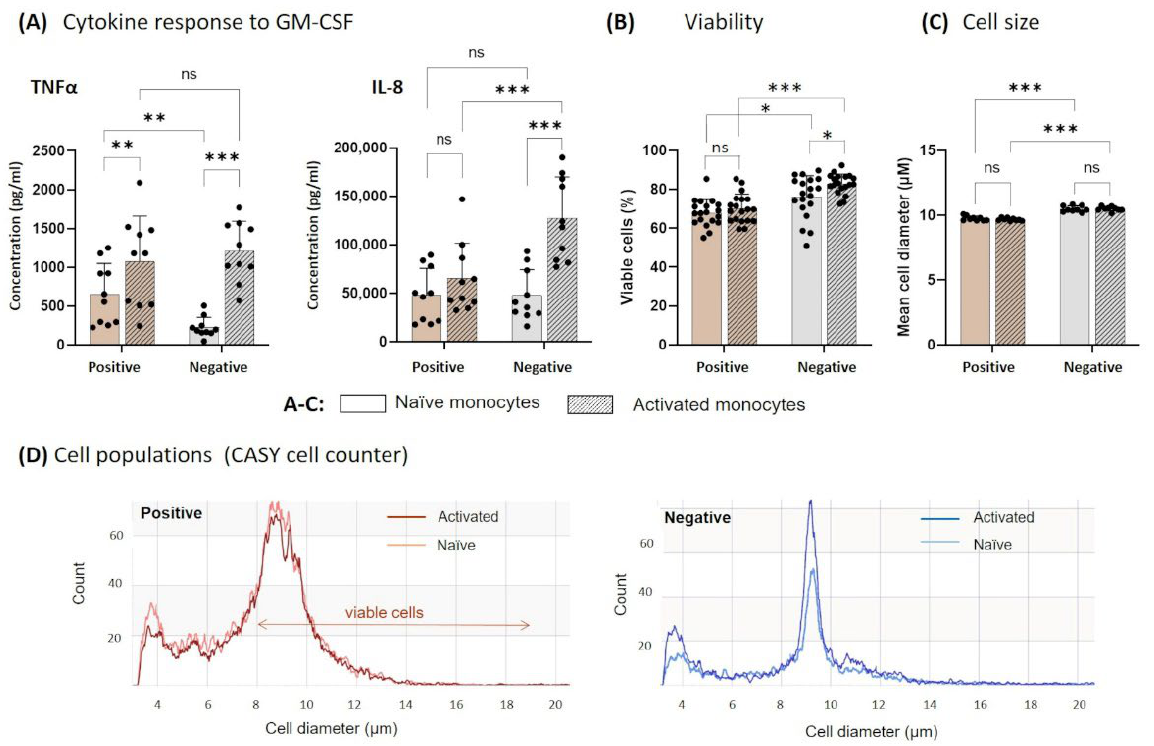
Figure 4. Effect of isolation method on cytokine response, viability, cell size, and functionality of blood-derived monocytes. After isolation from whole blood, monocytes were cultured ex vivo with GM-CSF (=activated) or left unstimulated (=naïve) for 16 h in suspension culture. ( A ) The non-adherent cells were collected, and secreted cytokines TNF- α and IL-8 were measured in cell culture supernatants by ELISA. ( B ) The viability and the cell size ( C ) were measured using the CASY cell counter. ( D ) A representative result of the gated monocyte population is shown based on cell diameter and cell counts. Results are presented as single dots representing one sample. Bars indicate means + SD. Pairwise comparisons were calculated using the Tukey–Kramer test. ( A ): n = 10, ( B , C ): n = 19; *** p < 0.001, ** p < 0.01, * p < 0.05., ns = not significant Abbr.: GM-CSF, granulocyte-macrophage